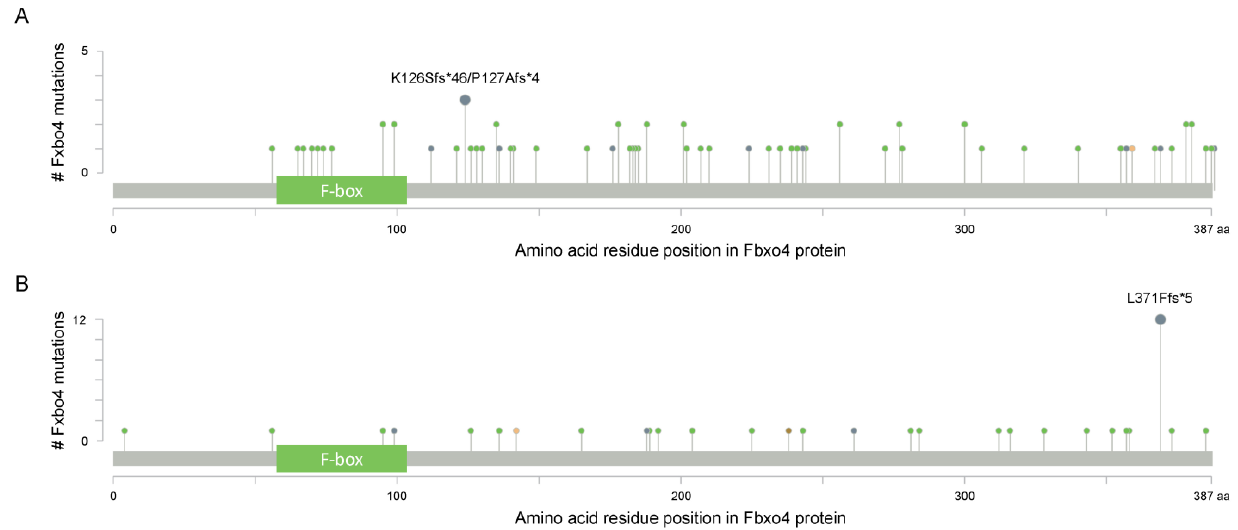
Figure 3. The cBioportal analysis reveals the existence of FBXO4 mutations (www.cbioportal.org (accessed on 12 April 2022)). ( A ) The identified mutations of FBXO4 in tumor tissues from the TCGA PanCancer Atlas Studies; all PanCancer related tumors are included for this analysis; there are 10,967 samples in total. ( B ) The identified mutations of FBXO4 in cells from the Cancer Cell Line Encyclopedia (Broad, 2019); all cells in Cancer Cell Line Encyclopedia (Broad, 2019) are utilized for this analysis. x -axis indicates the amino acid residue position of Fbxo4 protein while y-axis indicates the number of mutations for each highlighted residues.